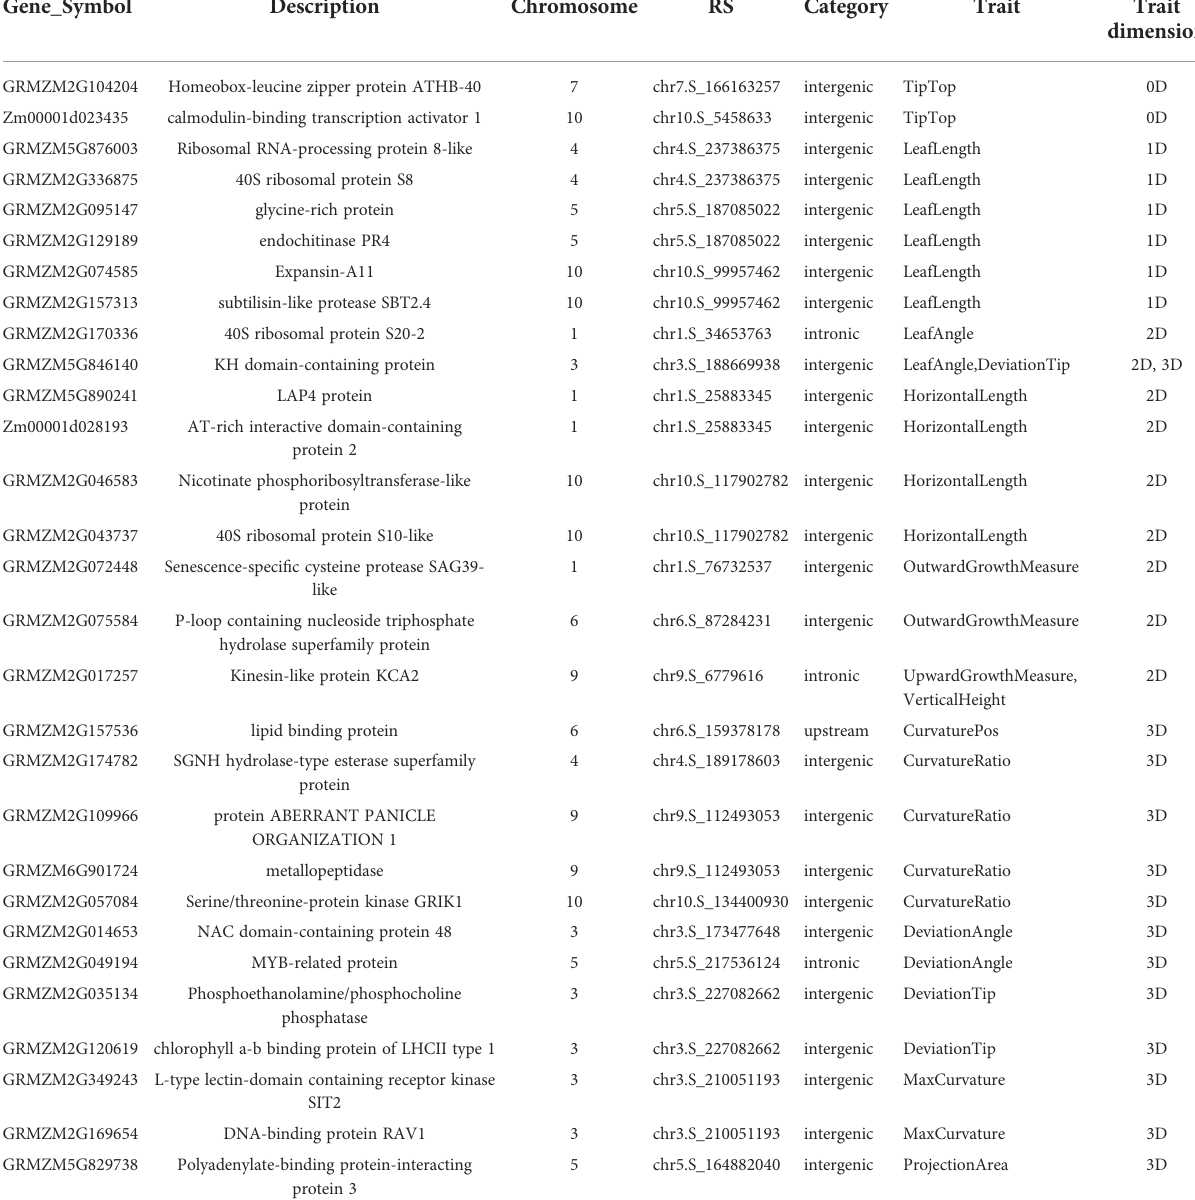
TABLE 3 Detailed functional descriptions of 29 genes annotated by both Top1 and multi-method validated SNPs.